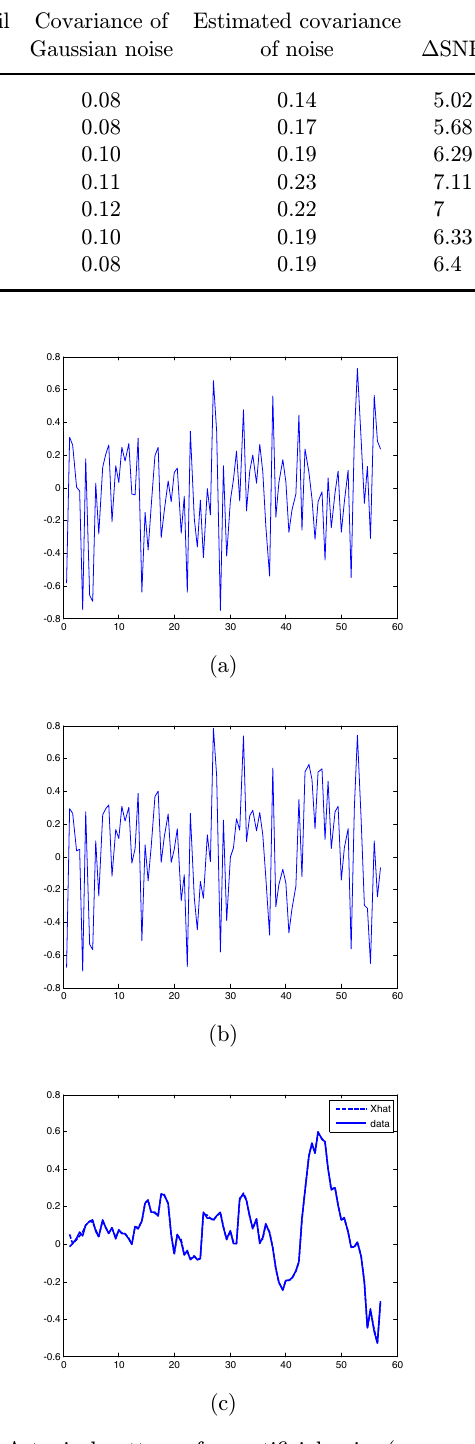
Fig. 4. A typical pattern of an arti¯cial noise (we assume as white and Gaussian), (b) The noise in (a) added to an fNIRS signal, (c) The contaminated signal in (b) is cleaned by ARMA based method (dashed line) and the original motionless signal (solid line).